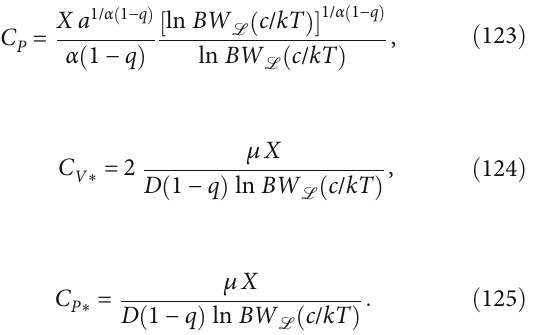
Figure 4: (a) Graph of C when q ′ , r vary and q = 0 : 4, T = 2 , P = 3 , D = 1 , and k = A = 1 . (b) Graph of C V ∗ P = 4 , D = 1 , and k = A = 1